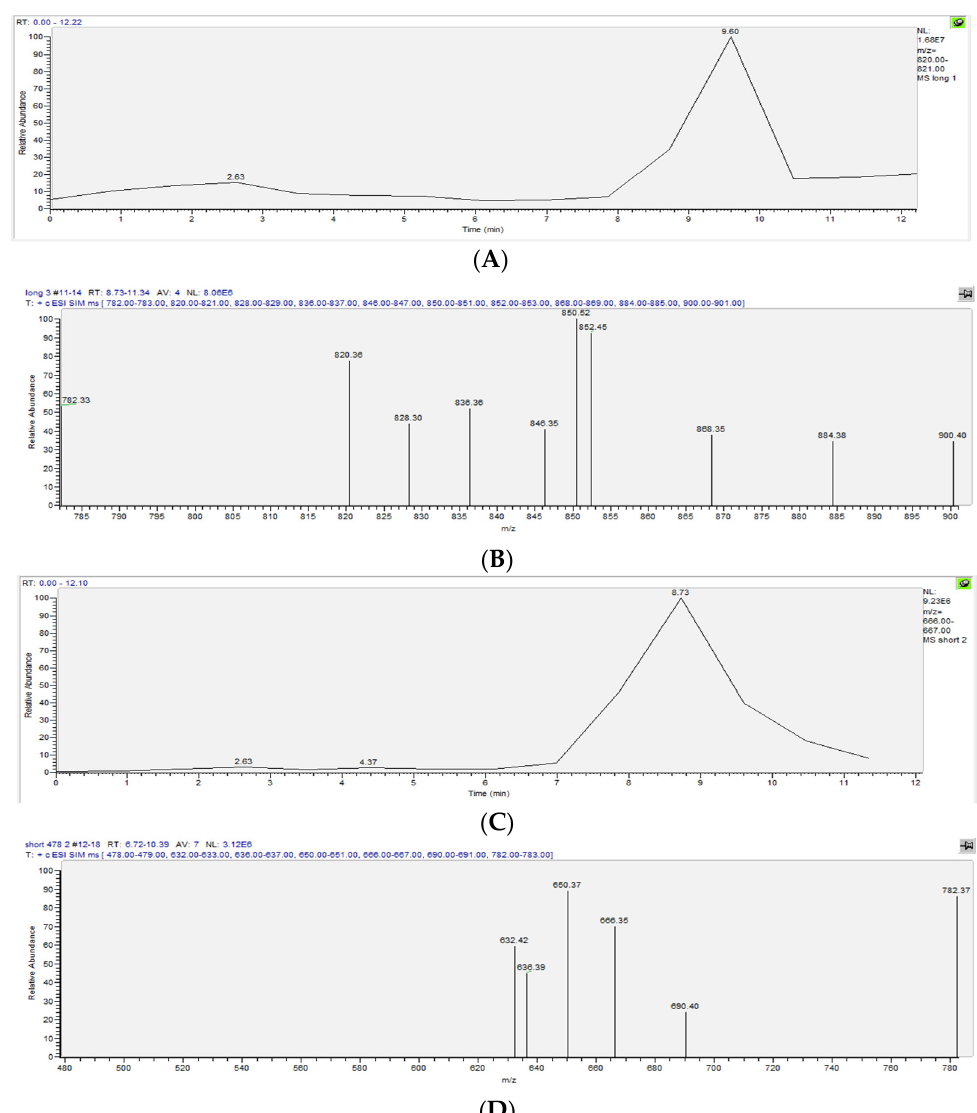
Figure 7. ( A ) EIC and ( B ) ESI-MS spectrum of the in vitro ox-PAPC product m/z 820.5. ( C ) EIC and ( D ) ESI-MS spectrum of the in vitro ox-PAPC product m/z 666.0. Ox-PAPC was obtained by in vitro oxidation (FeCl 2 : H 2 O 2 = 2:1) of 100 µg/mL native PAPC standard at 37 °C for 15 min. The LC- ESI/MS conditions were as in Figure